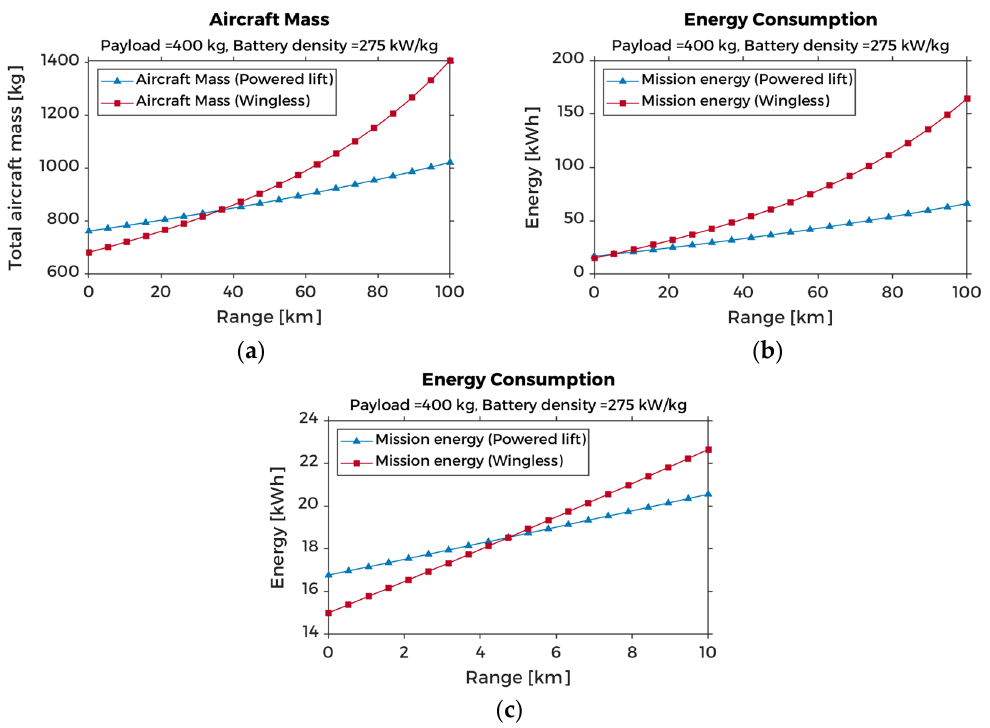
Figure 12 . ( a ) Aircraft mass and ( b , c ) energy consumption results for powered lift and wingless eVTOL aircraft types up to 100 km range.